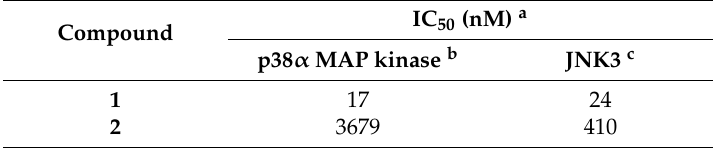
Table 1. Evaluation of pyridinylimidazoles 1 and 2 for p38 α MAP kinase and JNK3 inhibition.